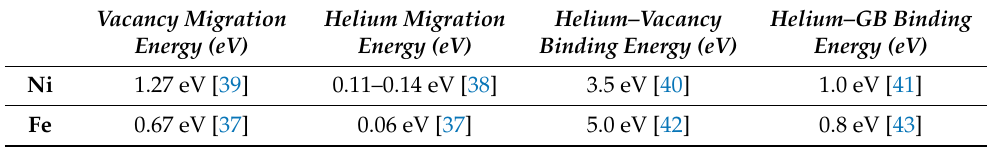
Table 1. Table of binding and migration